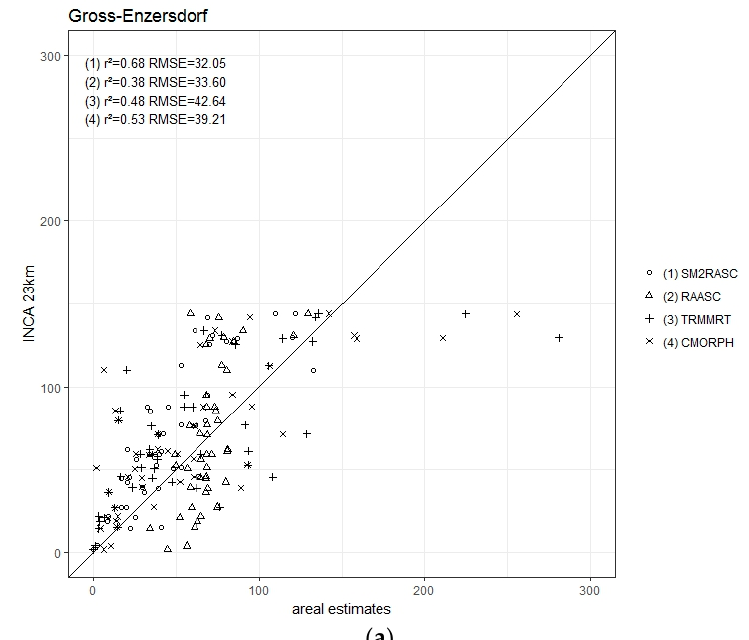
Table 3. Statistical parameters of rainfall differences between point-measured (ZAMG) (as reference) and INCA 1km for the months March until July 2007–2015.